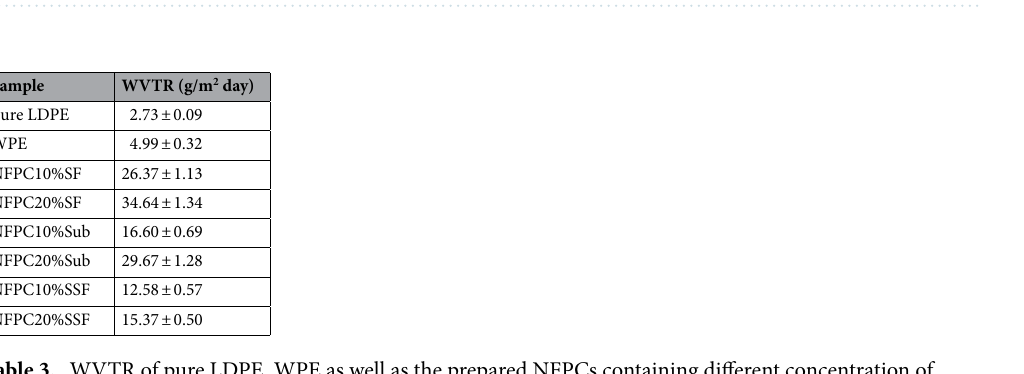
Figure 6. Biodegradability of WPE and the prepared NFPCs.